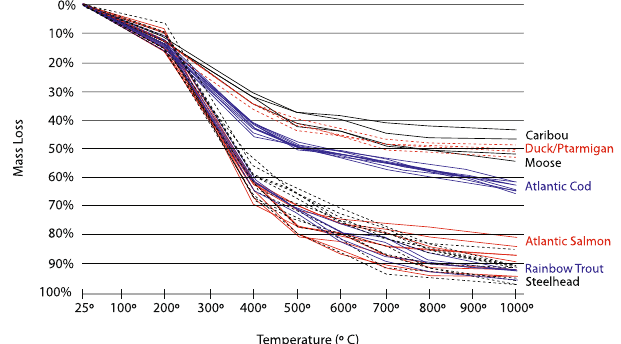
Figure 2. Mass Losses in Salmonid, Codfish, Caribou, Moose, Duck, and Ptarmigan Bones throughout the Heat Treatment Process. All species lost a similar amount of weight at 200 °C owing to evaporating H 2 O and melting fats; salmonid specimens show a sharp decrease at 400 °C resulting from greater losses of their larger organic matter fractions; caribou, moose, and duck contain the lowest amounts of organic matter and show similar mass loss trajectories.